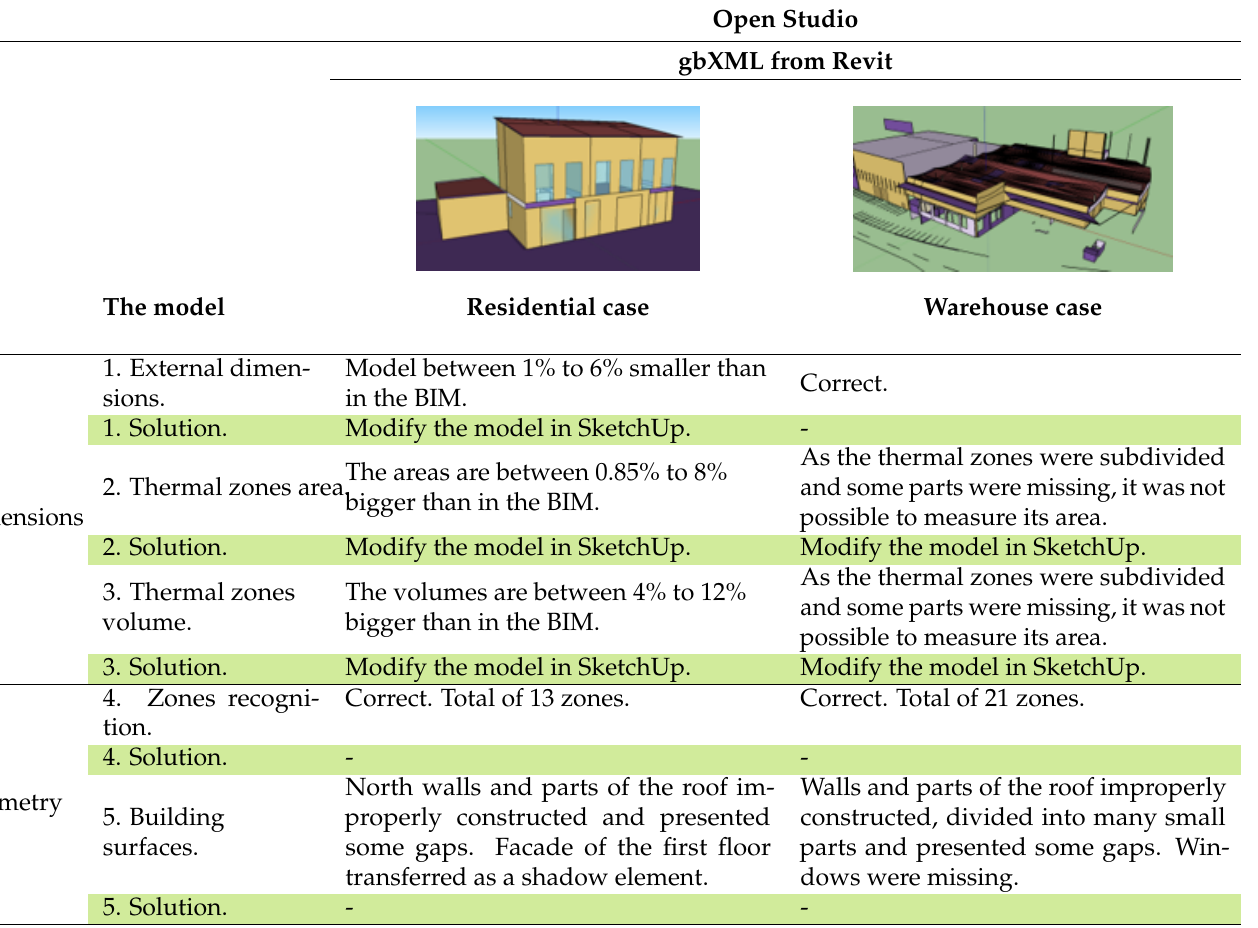
Figure 8. Warehouse gbXML file imported in Open Studio. Table 2. Comparative table between the gbXML files imported in Open